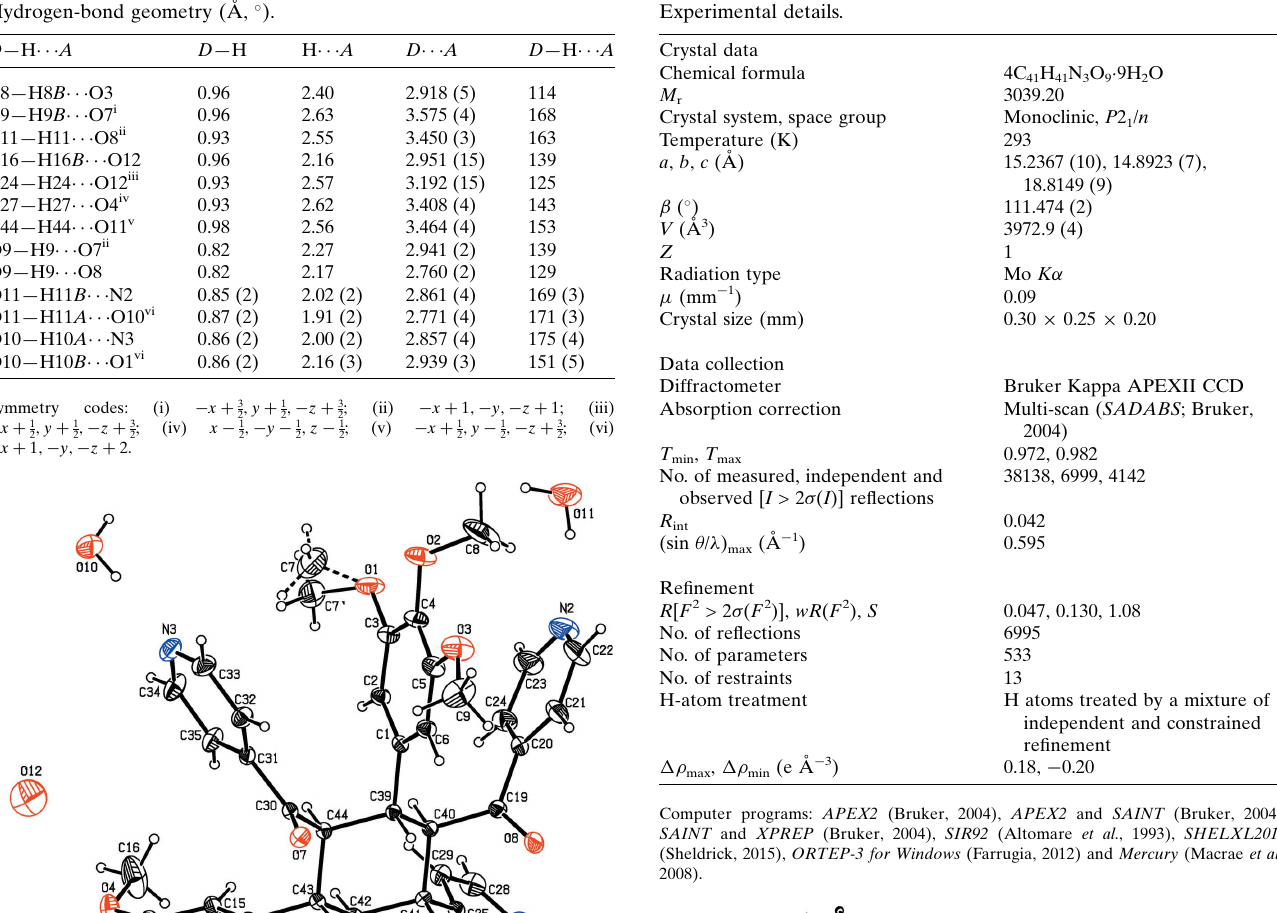
Table 1 Hydrogen-bond geometry (A˚ , (cid:3) ).